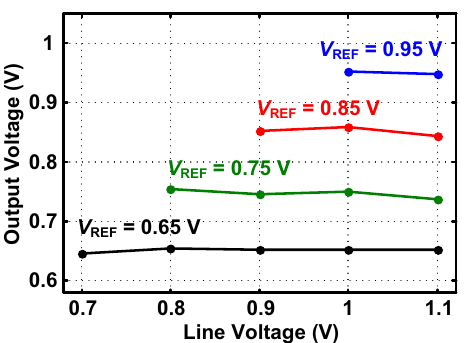
Figure 14. The output voltage under the variations of line voltage.